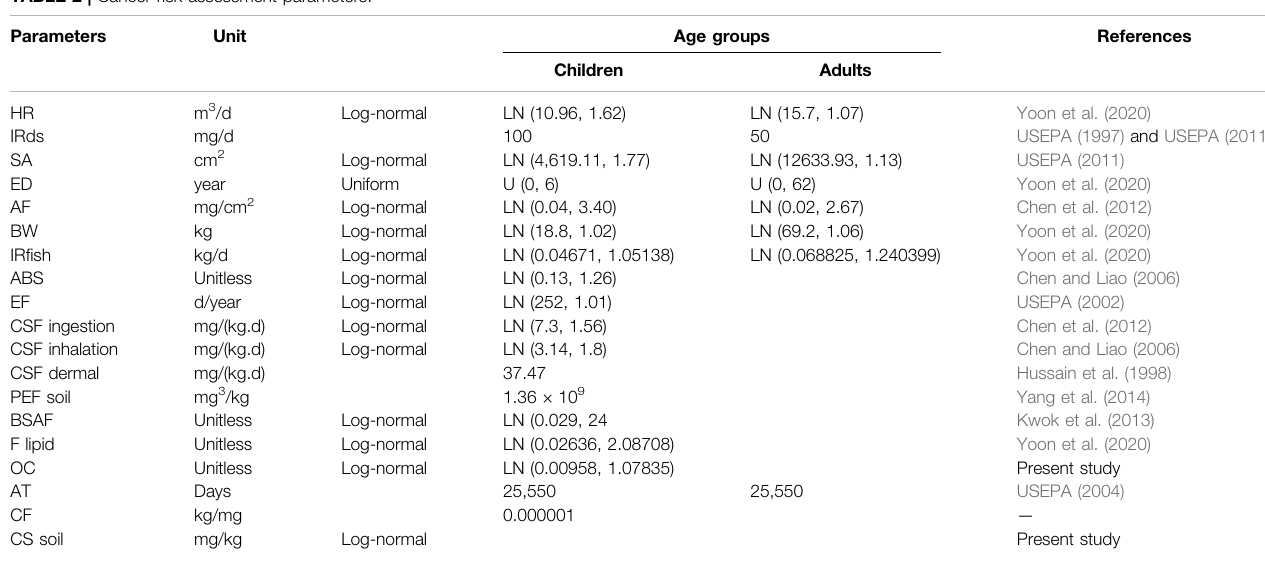
TABLE 2 | Cancer risk assessment